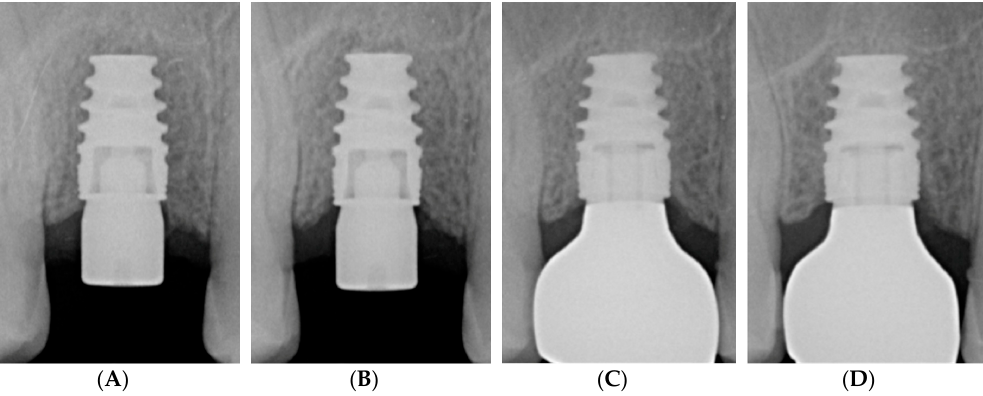
Figure 7. Radiographic follow-up of a NobelActive ® Wide Platform implant: ( A ) following implant placement; ( B ) after 3 months; ( C ) after 1 year; ( D ) after 3 years.